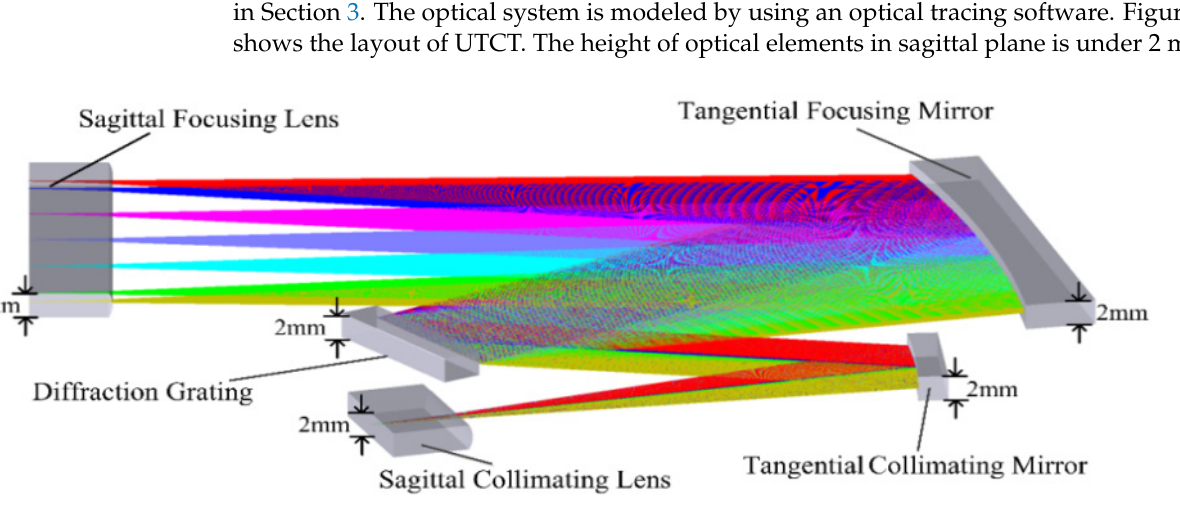
Figure 4. Spot diagrams at several specific wavelengths.